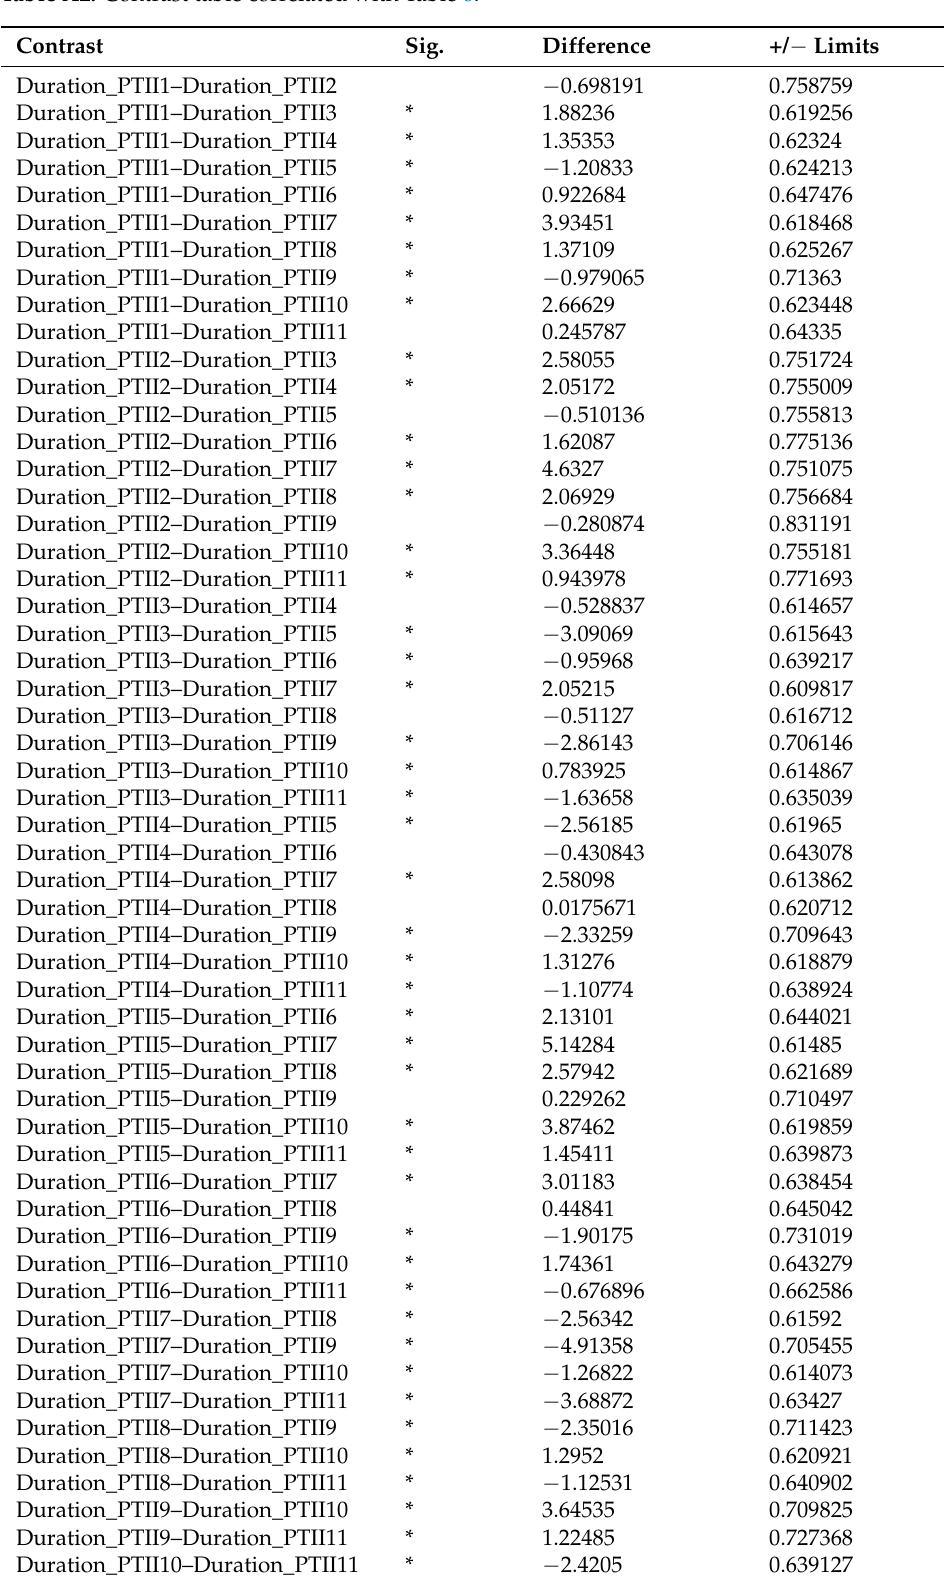
Table A2. Contrast table correlated with Table